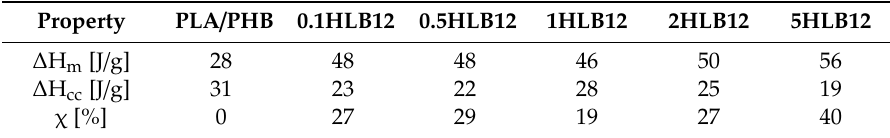
Table 3. Thermal properties of the neat blend and HLB12-containing